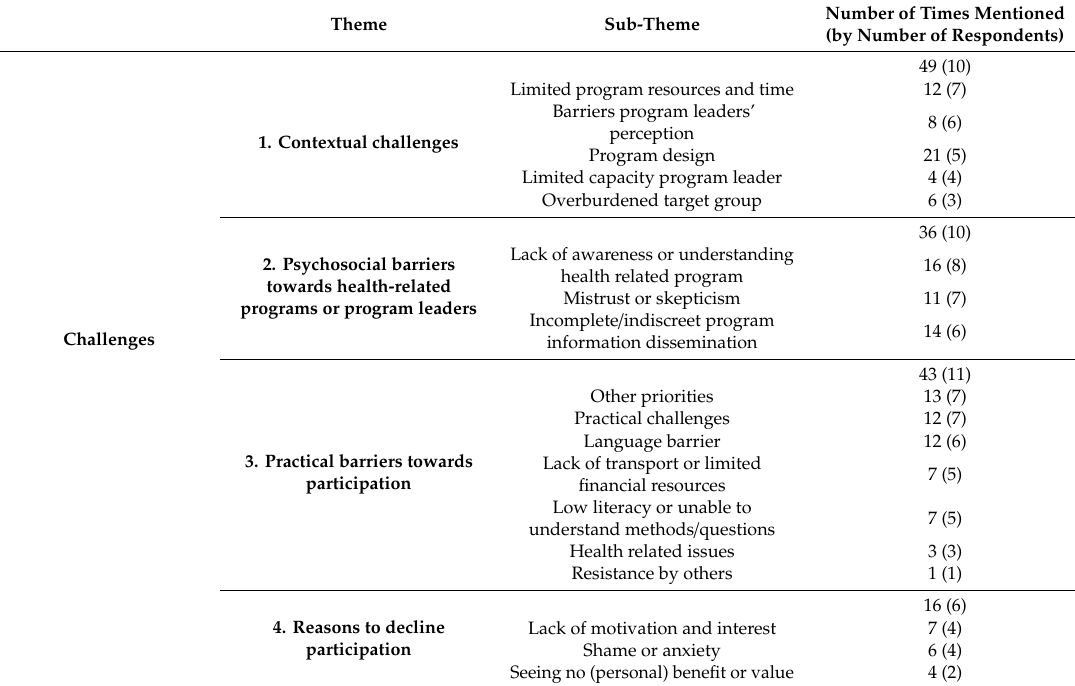
Table 3. Structured overview of key challenges and success factors identified from the